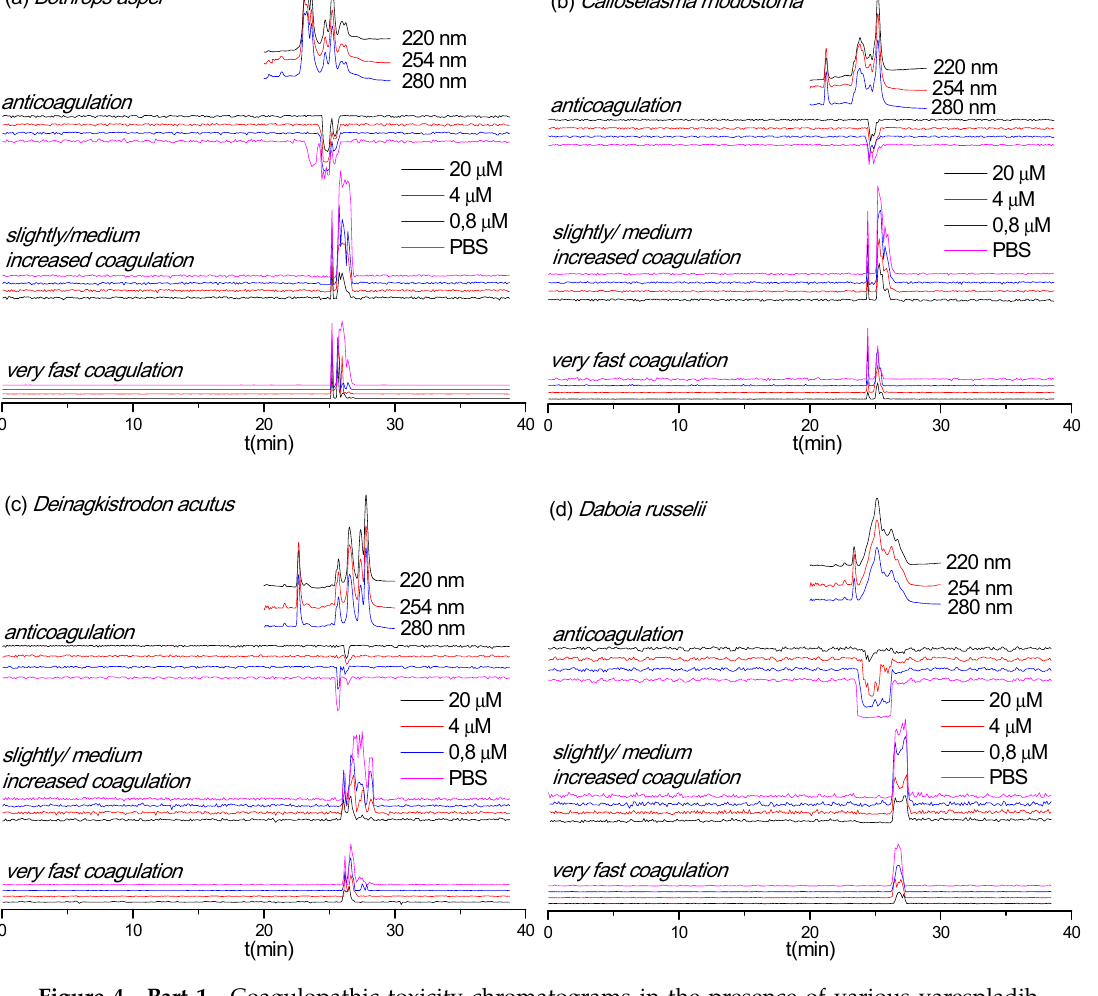
Figure 4. Part 1 —Coagulopathic toxicity chromatograms in the presence of various varespladib concentrations for nanofractionated venom toxins from ( a ) B. asper , ( b ) C. rhodostoma , ( c ) D. acutus , ( d ) D. russelii , ( e ) E. carinatus , ( f ) E. ocellatus, and ( g ) O. scutellatus . Top traces are the online LC-UV chromatograms recorded at 220, 254, and 280 nm for the respective venoms (allowing a correlation with LC-MS data and proteomics data from Slagboom et al. [33]). (figure continues on next